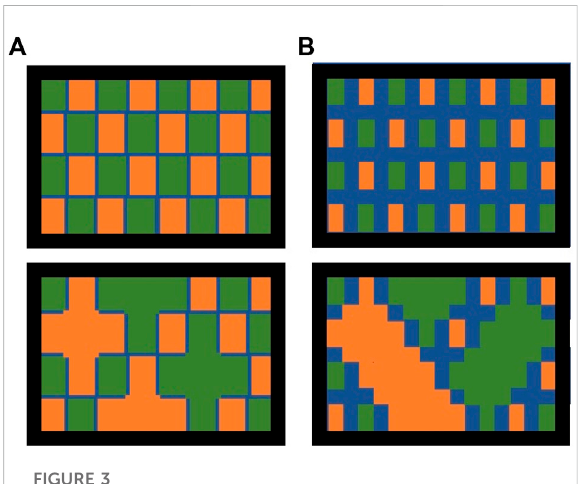
FIGURE 3 Possible arrangements of molecular clusters within the liquid phase. Orange represents one molecular species and green represents another molecular species. The blue lines represent boundaries between different clusters of molecules and are mixed at a molecular scale. (A) Large cluster sizes, enthalpy- controlled packing arrangement. (B) Small cluster sizes, entropy- controlled packing arrangement. In the top views, clusters of comparable size are distributed uniformly throughout the liquid phase. In the bottom views, clusters of variable size are distributed throughout the